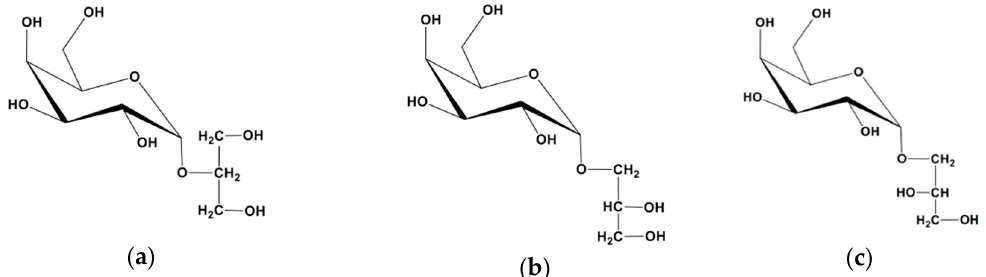
Figure 1. Structures of floridoside and isofloridoside: ( a ) floridoside; ( b ) D -isofloridoside; ( c ) L -isofloridoside.